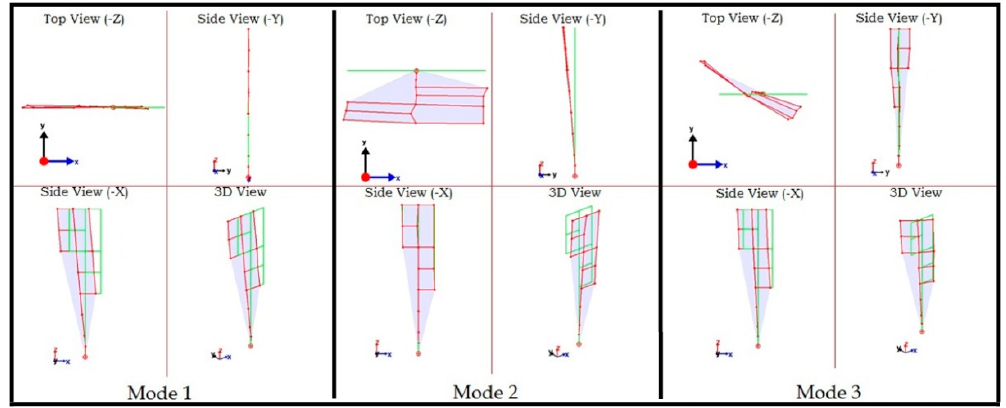
Figure 20. The first three mode shapes after the second iteration. All nodes are synchronized.